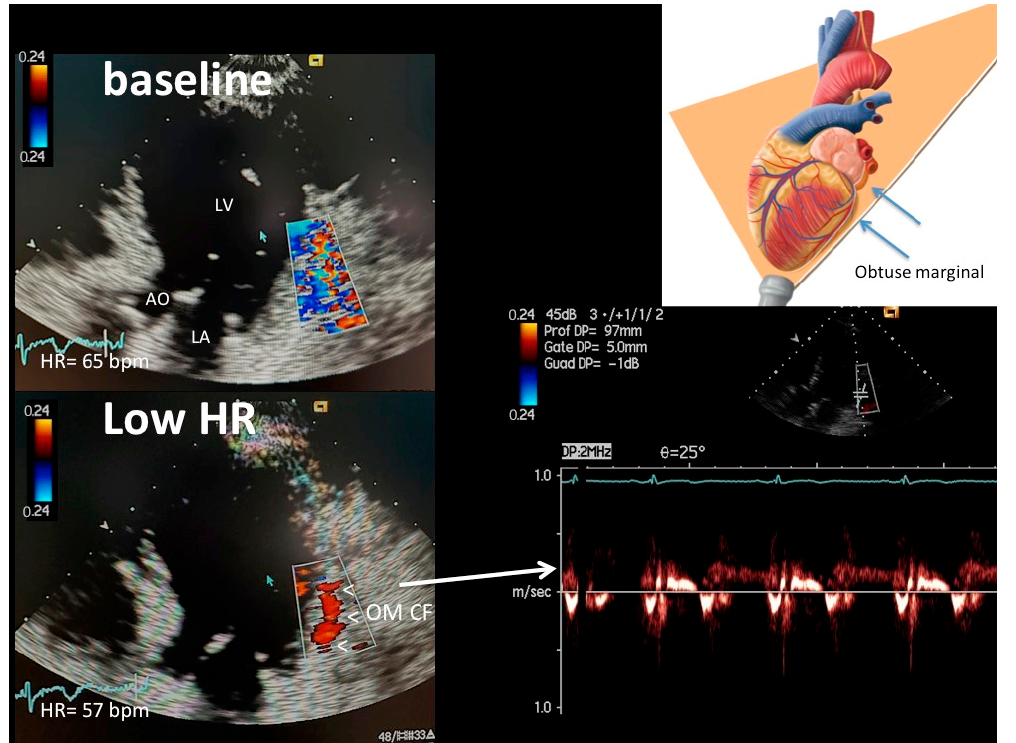
Figure 3. An example of OM color flow (plane orientation at the top right corner) at high HR (65 b/m) (upper left) and after HR reduction (57 b/m) (bottom left): at the baseline with higher HR, no flow is detected (only clutter artifacts); after HR lowering (<60 b/m), optimal color signal is recorded (indicated by arrowheads) in the proximal OM so allowing color-guided pulsed-wave Doppler sampling of optimal quality (bottom right). OM CF = color flow in the obtuse marginal; LV = left ventricle; AO = aorta; LA = left atrium.